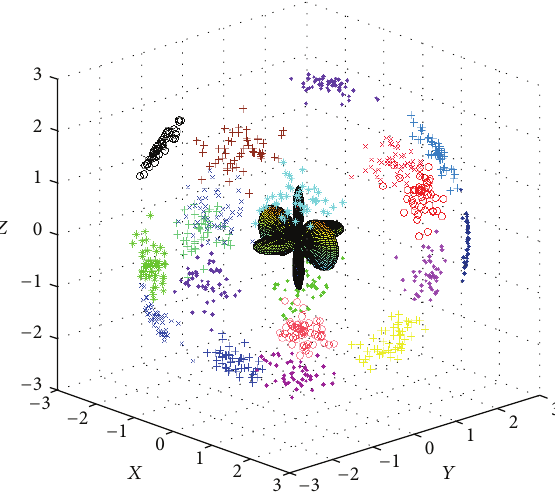
Figure 11: Scattering